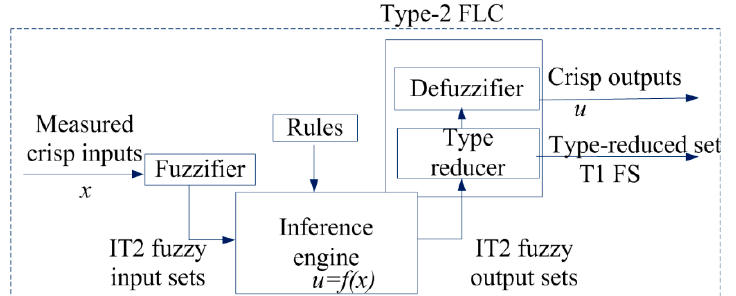
Energies 2019 , 12 , x FOR PEER REVIEW Figure 3. The general structure of the interval type-2 fuzzy logic control. Figure 3. The general structure of the interval type-2 fuzzy logic control.